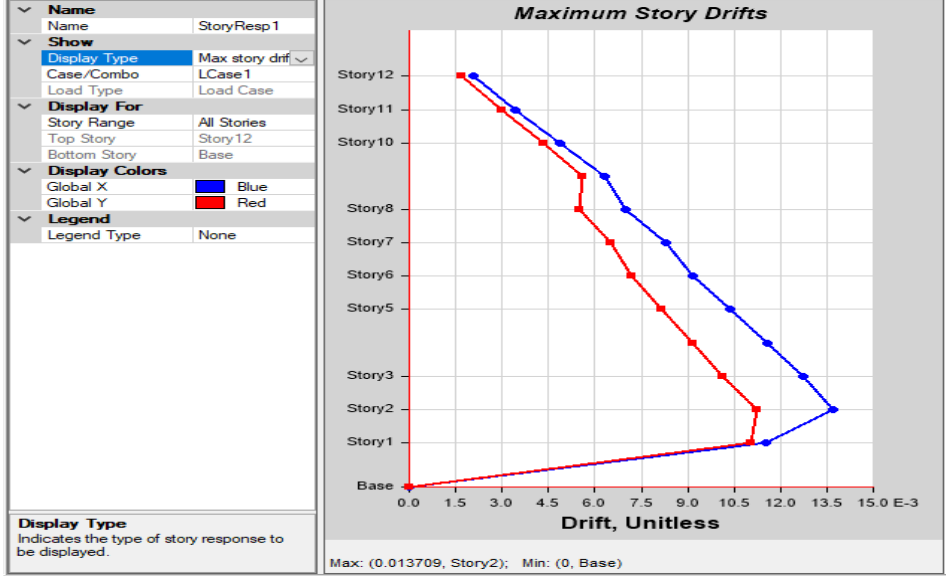
Figure 10. Maximum story drift.